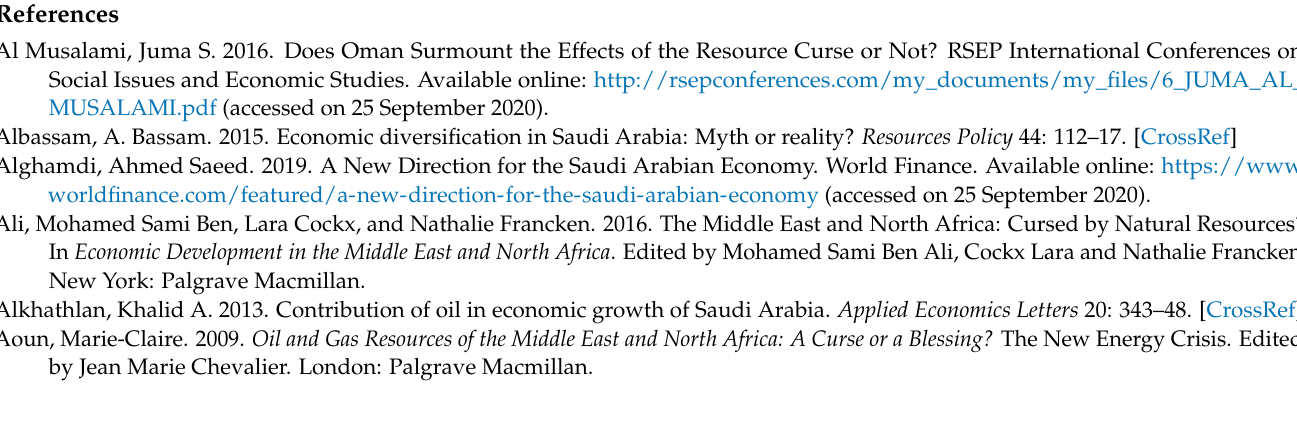
Figure A9. Square of CUSUM Test (OMAN).